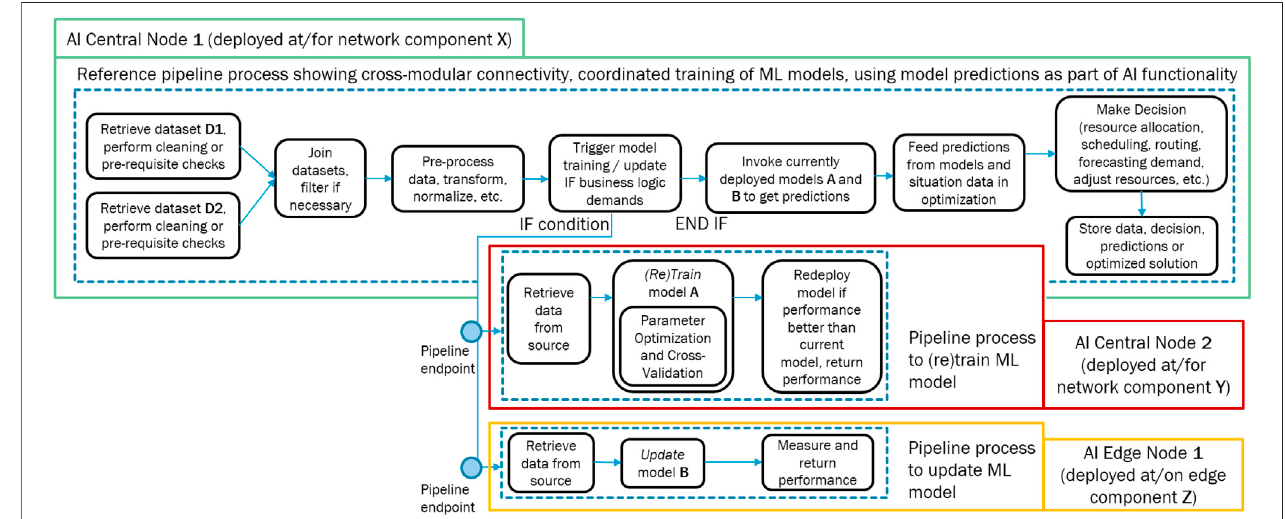
FIGURE 15 | A reference pipeline processes illustrating cross layer connectivity and